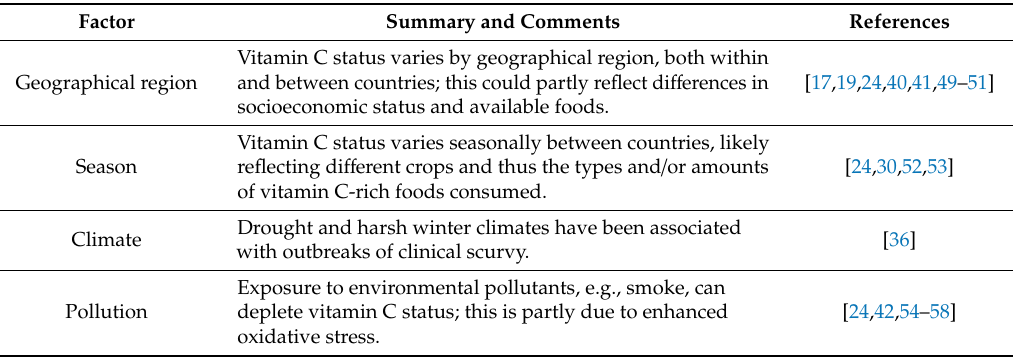
Table 3. Environmental factors a ff ecting vitamin C status. Summary and